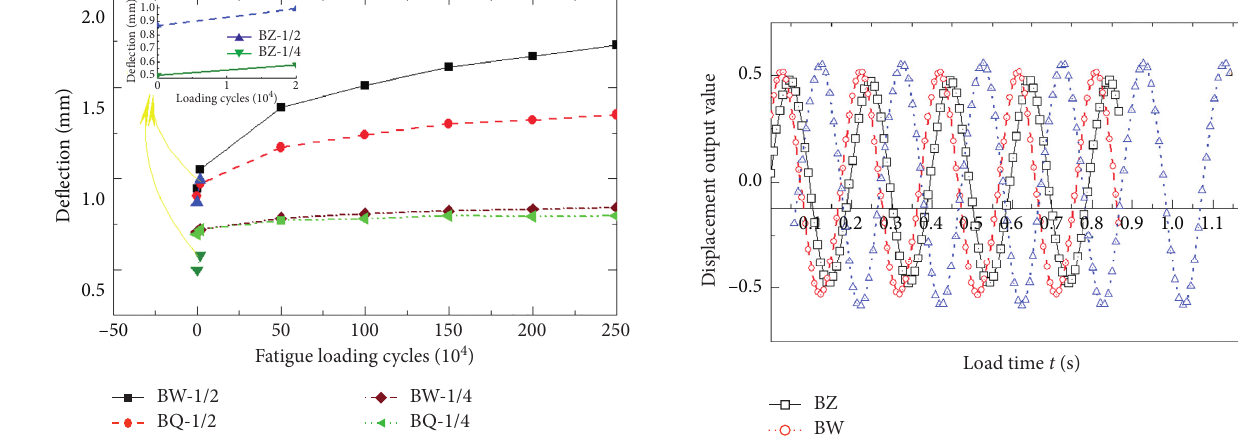
Figure 14: Development of static deflection under fatigue testing.